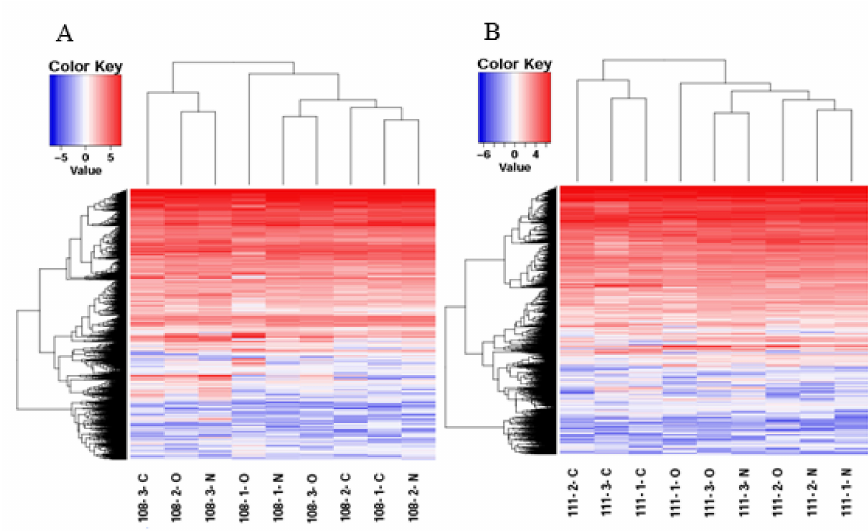
Figure 4. DEG dendrograms of the ‘108’ and ‘111’ treatment groups. Dendrograms showing the clustering of DEGS in the ( A ) ‘108’ and ( B ) ‘111’ treatment groups. Pearson correlation co-e ffi cient between pairwise, and pairwise was calculated according to the gene expression of each sample to indicate the similarity between the two treatments. Using system clustering (i.e., hierarchical cluster) to classify and group samples with high similarity, the clustering results of ‘108’ and ‘111’ were obtained. C, control; N, neighboring; O,